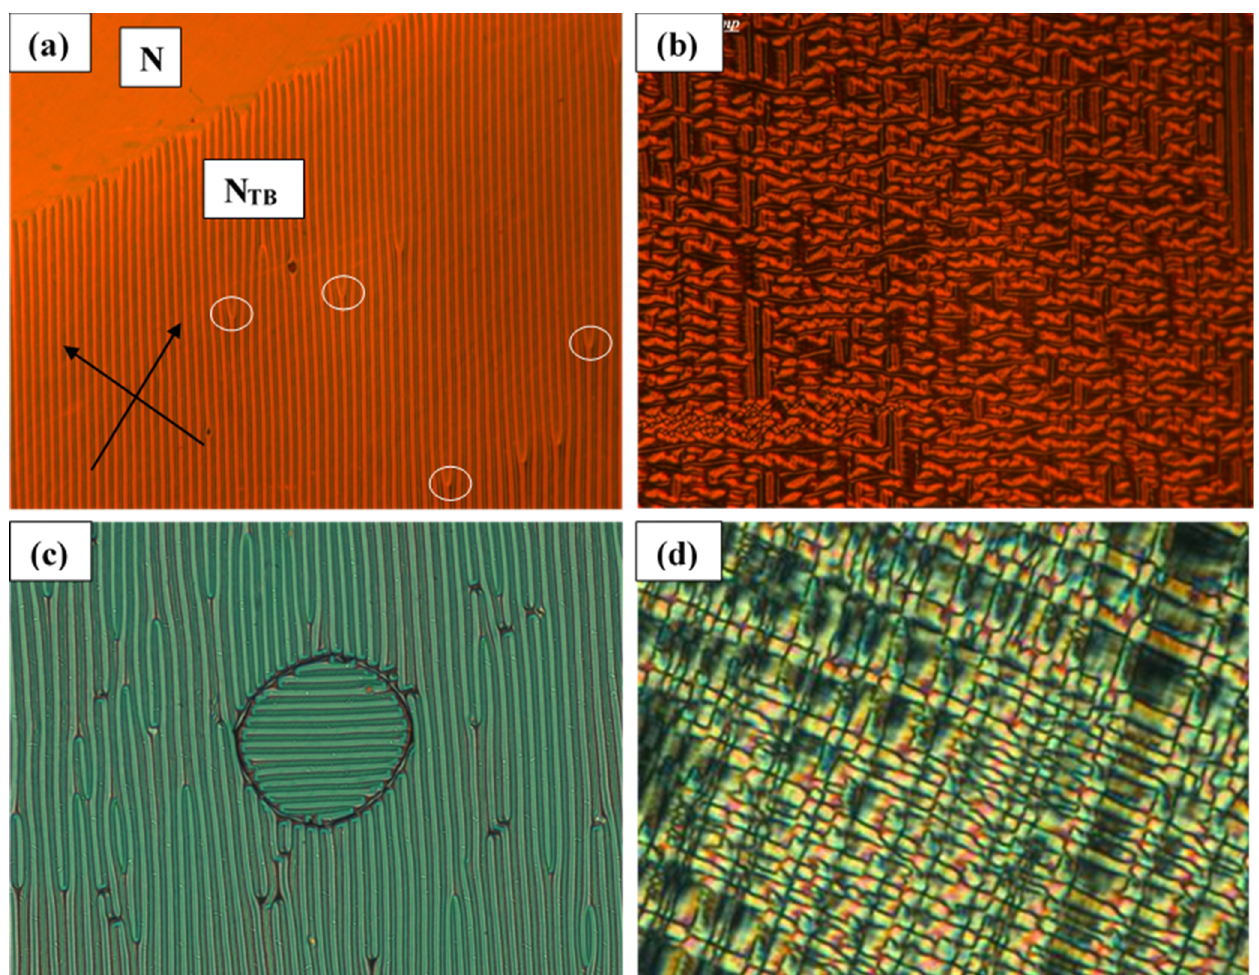
Figure 11. Material used is MGTP7. The N TB textures are recorded in the planar-twist-aligned cells. µm. ( a ) Texture in the vicinity of the N–N TB transition. The cell gap is 5.53 µm. The stripes emerge spontaneously at a temperature just below the N–N TB transition temperature, the stripes direction bisects the angle between the two rubbing directions of the cell. Stripe periodicity in this cell is a function of temperature in the N TB . In case of a small temperature gradient in the cell, the stripe periodicity is adjusted via fork defects (highlighted by the white circles). ( b ) Temperature is 4 °C below the phase transition temperature, a complex 2-dimensional pattern is seen replacing the stripes. ( c ) Temperature is 1 °C below the N–N TB transition temperature. No field is applied. The polarisers are vertical and horizontal to the figure here. The rubbing direction on each electrode is ~45° to the polariser direction. Two stripe-domains are seen at ± 45° to the polariser direction. ( d ) An alternative pattern of ‘crosses’ is observed after an application of the electric field applied to a positive Δε , material M1 in a twisted cell of 8 μ m thickness. Temperature is 5 °C below the N–N TB phase transition.